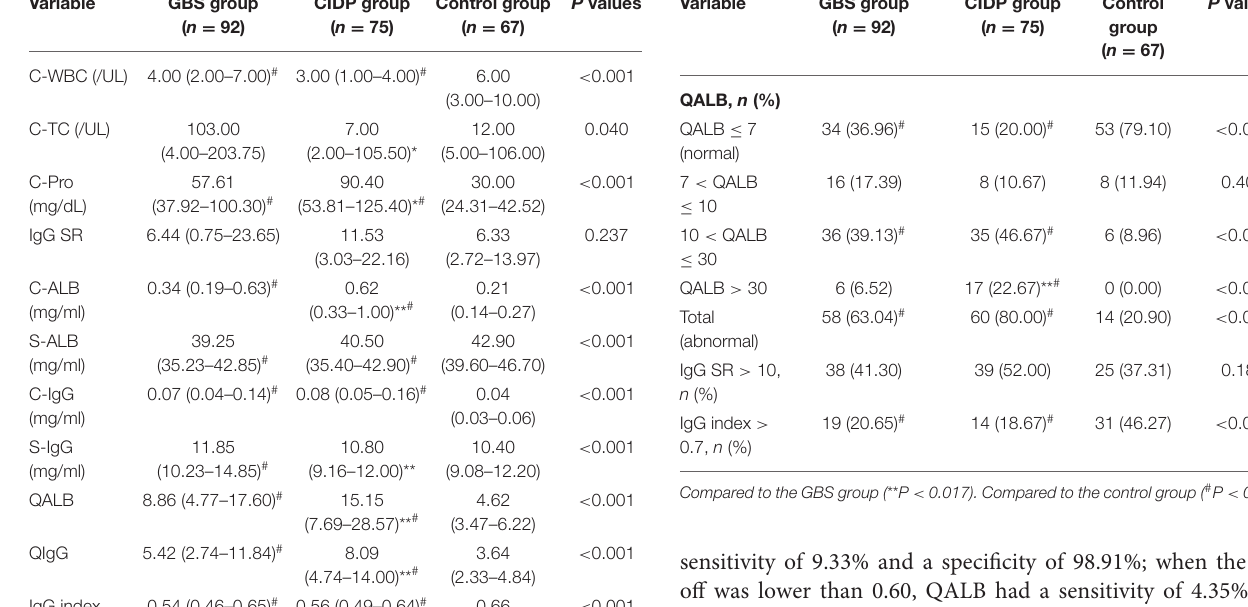
TABLE 3 | Comparison of the IgG SR, QALB, and IgG index positive rates in the GBS, CIDP and control groups.